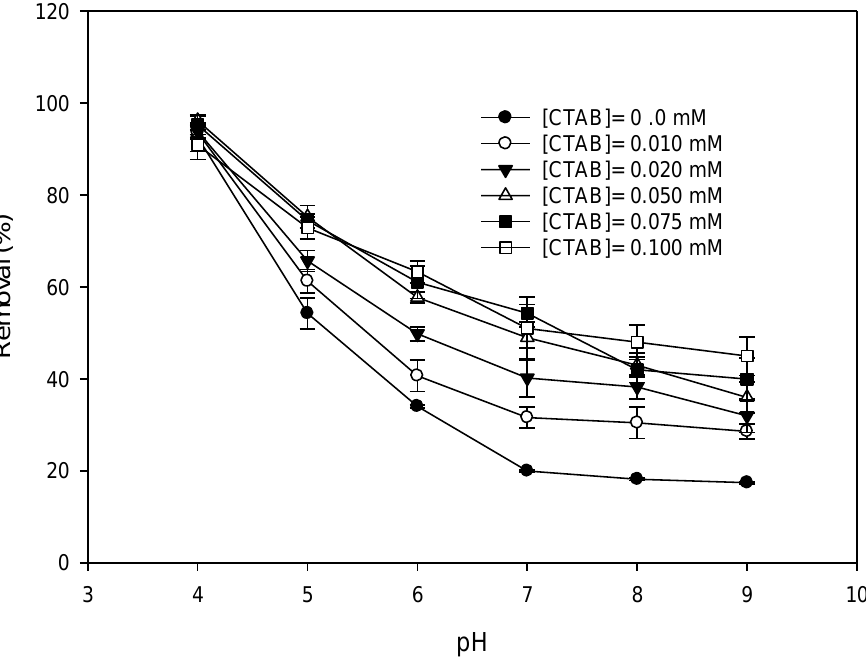
Figure 4. Effect of the dosage of CTAB on the removal of diclofenac (DIC) by MnO 2 . (Reaction time = 1 day, initial DIC conc. = 100 µM, (MnO 2 ) = 100 mg L -1 , T = 25 °C).